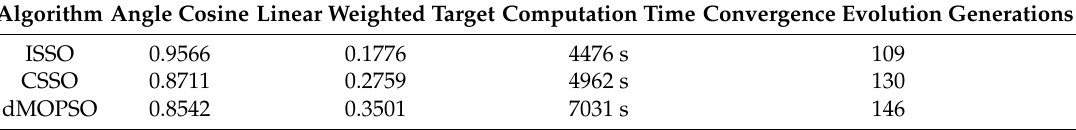
Table 7. The HILS evaluation of the results of different algorithms for Jinpu line No.1 in Dalian scenario. Algorithm Angle Cosine Linear Weighted Target Computation Time Convergence Evolution